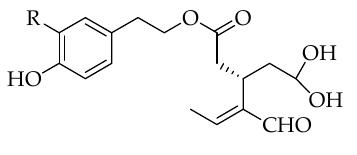
Figure 7. Monohydrate forms of oleocanthal 13 and oleacein 14 .